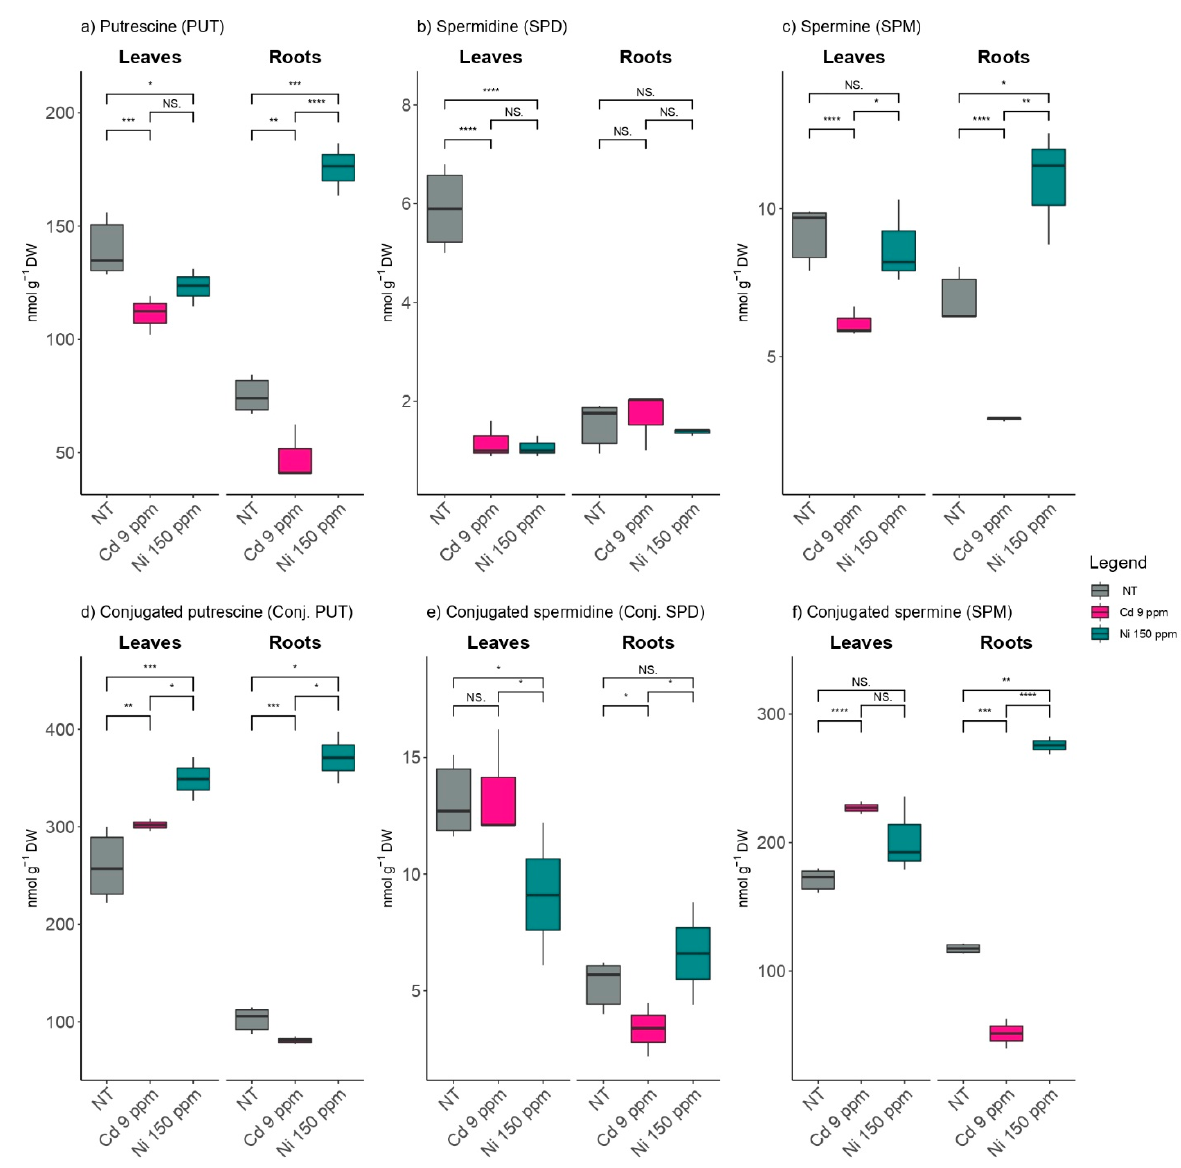
Figure 4. The effects of elevated Cd and Ni soil contents on amounts of accumulated free polyamines (( a ) putrescine-PUT, ( b ) spermidine-SPD, and ( c ) spermine-SPM), as well as conjugated polyamines (( d ) conjugated putrescine-conj. PUT, ( e ) conjugated spermidine-conj. SPD, and ( f ) conjugated spermine-conj. SPM) at root and leaf levels using NT-non treated soil. Cd 9 ppm-soil was supplemented to 9 mg Cd kg − 1 of soil dry weight and Ni 150 ppm-soil was supplemented to 150 mg Ni kg − 1 of soil DW. Significance levels: (NS) non-significant versus significant (*) <0.05; (**) <0.01; (***) < 0.001; and (****) <0.0001.